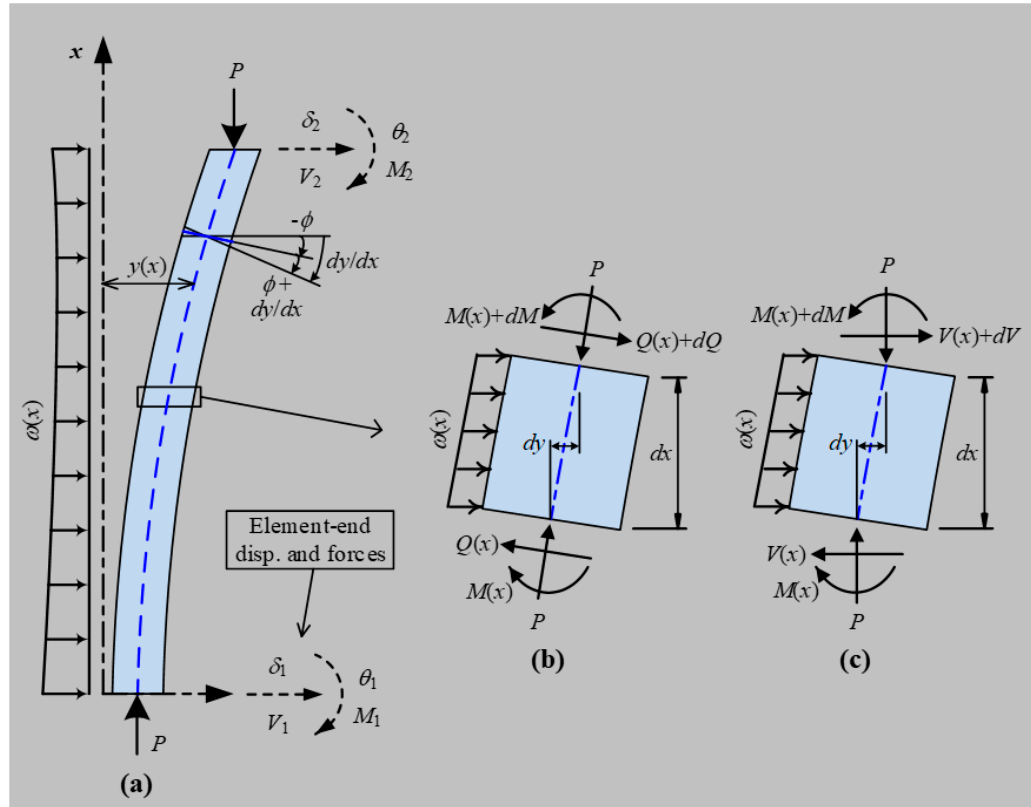
Figure 2. Equilibrium analysis of axial-loaded Timoshenko beam–column: ( a ) analyzed element; ( b ) equilibrium of element short segment with shear force Q (x) normal to the deformed element axis; ( c ) element short segment with shear force V (x) normal to the undeformed element axis.